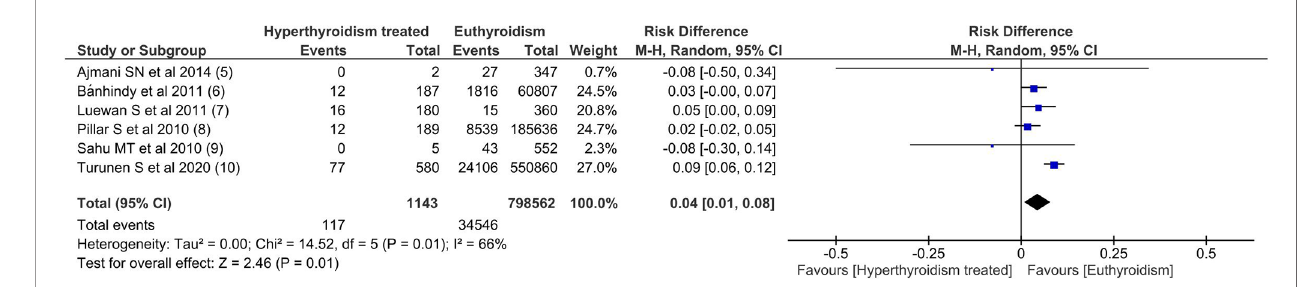
FIGURE 2 | Forest